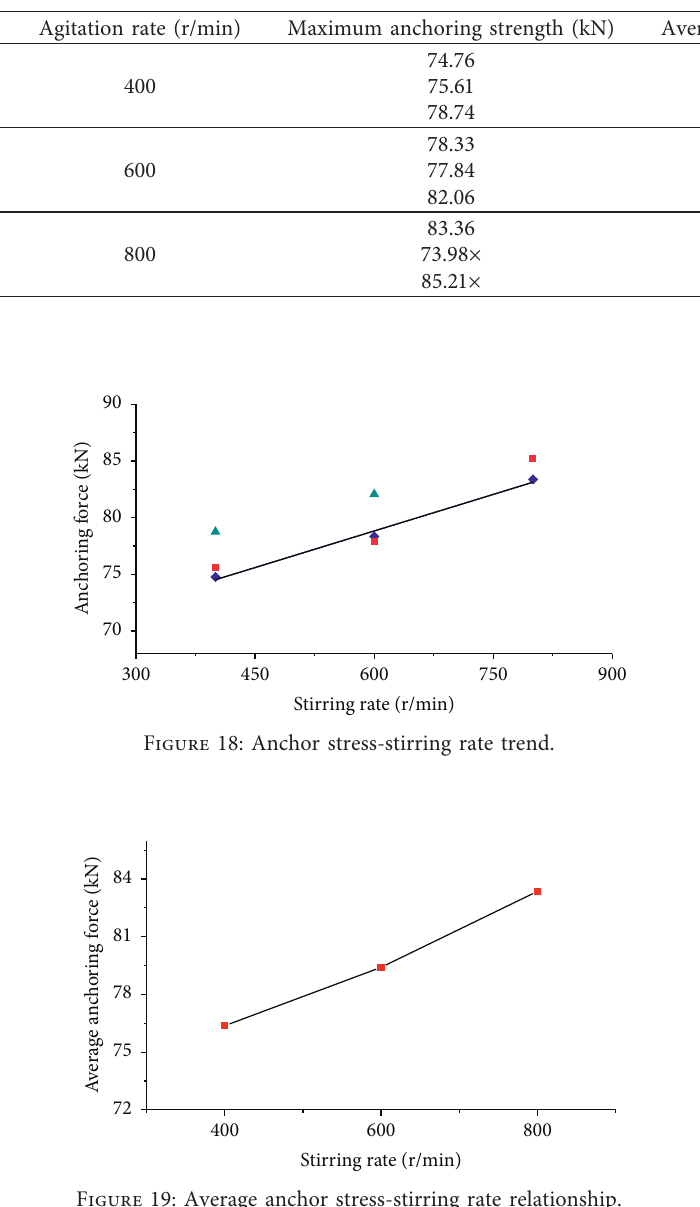
Table 4: Pull-out experiment data.